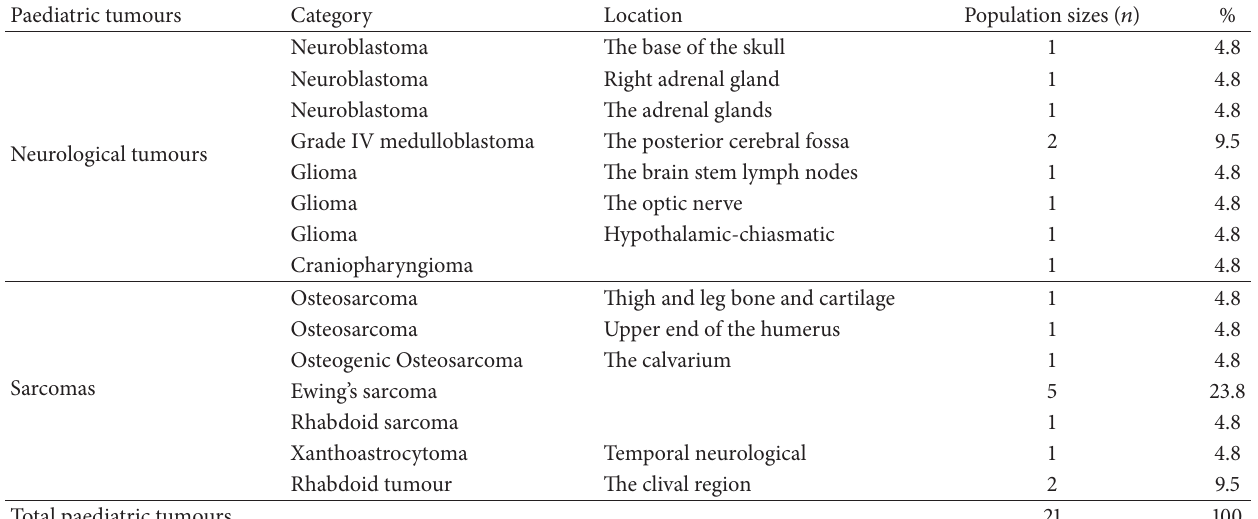
Table 5: Results, EpiHadron: list of cases identified by anatomical type for paediatric tumours.